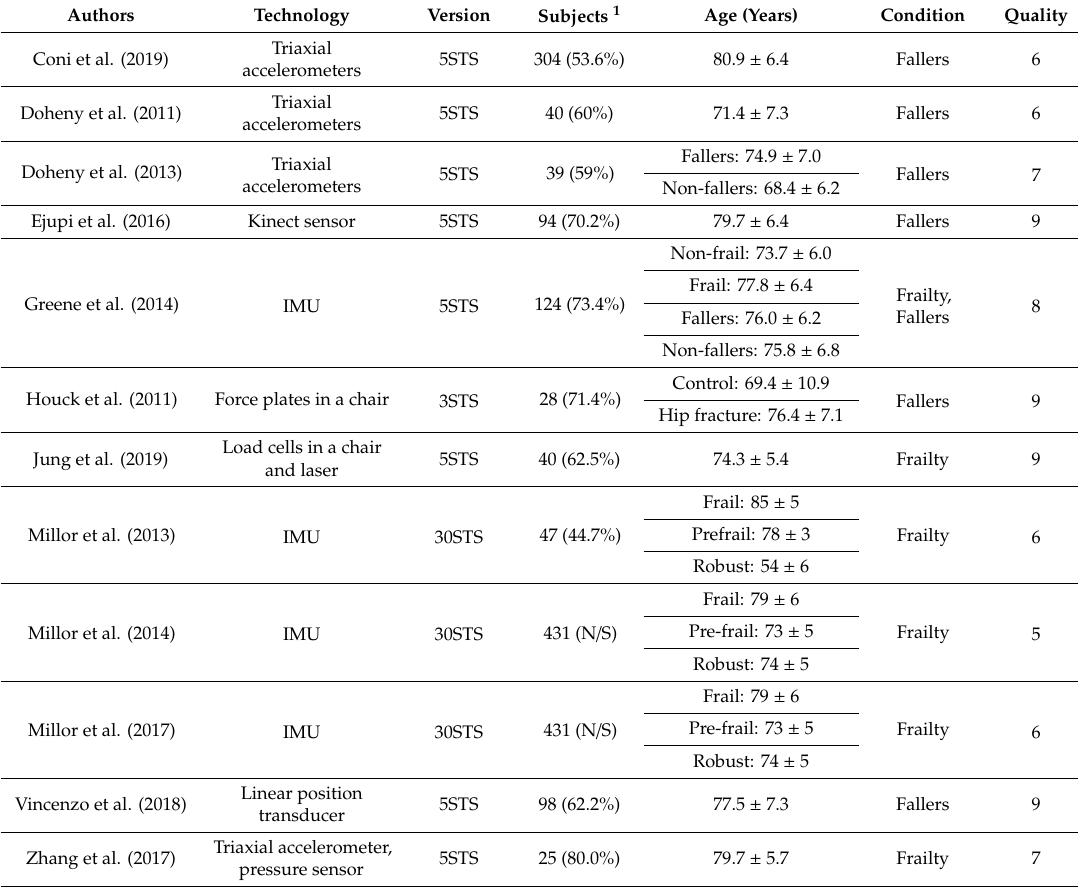
Table 1. Characteristics of the articles accepted after full-text screening.